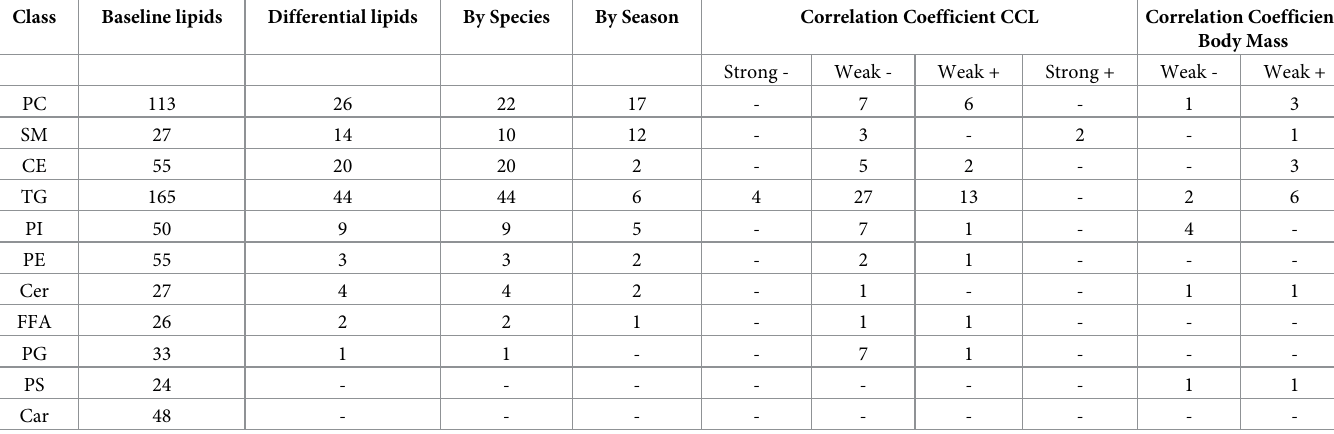
Table 2. Plasma lipid and metabolite classes isolated from sea turtle plasma, and correlation to length and mass. Class Baseline lipids